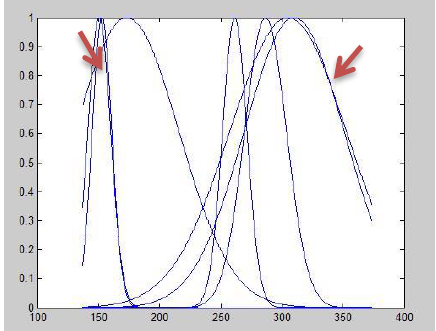
Figure 2. Membership function before merge.